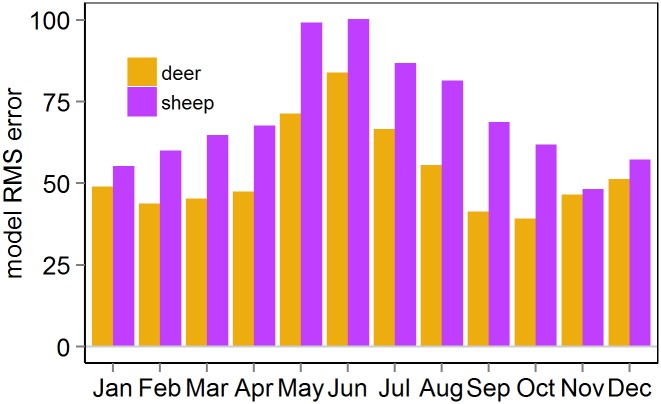
Monthly predictability (root mean square error RMS) of the movement in sheep and red deer.The plot reports systematic bias to those errors, which reflects an average global behaviour inferred from the data.